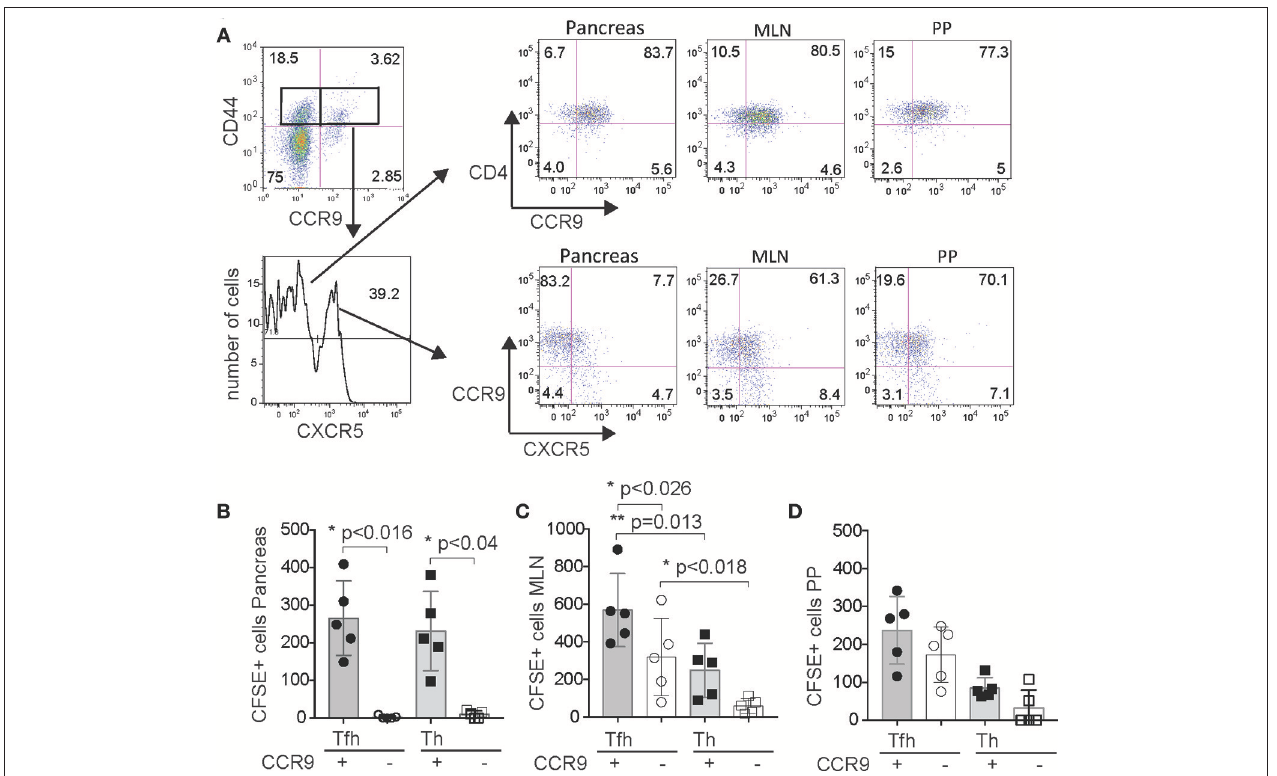
FIGURE 8 | CCR9 marks GIT-derived Tfh cells and Th cells that migrate to the pancreas. (A) FACS sorting strategy showing representative FACS dot plots gated on CD4 and then CD44 vs. CCR9 and FACS histogram of CXCR5 expression for purification of CCR9 + CXCR5 + Tfh cells, CCR9 − CXCR5 + Tfh cells, CCR9 + CXCR5 − Th cells and CCR9 − CXCR5 − Th cells from the PP and MLN, and representative FACS dot plots of CCR9 + / − Th cells and CCR9 + / − Tfh cells from the pancreas infiltrate, mesenteric lymph nodes (MLN) and Peyers patches (PP). 6 × 10 5 CFSE labeled cells from each of the 4 subsets were injected (i.v.) into age matched female NOD recipients ( n = 5/transfer group). Quantitation showing numbers of CFSE labeled CD4 + CCR9 + and CD4 + CCR9 − Tfh and Th cells recovered from the